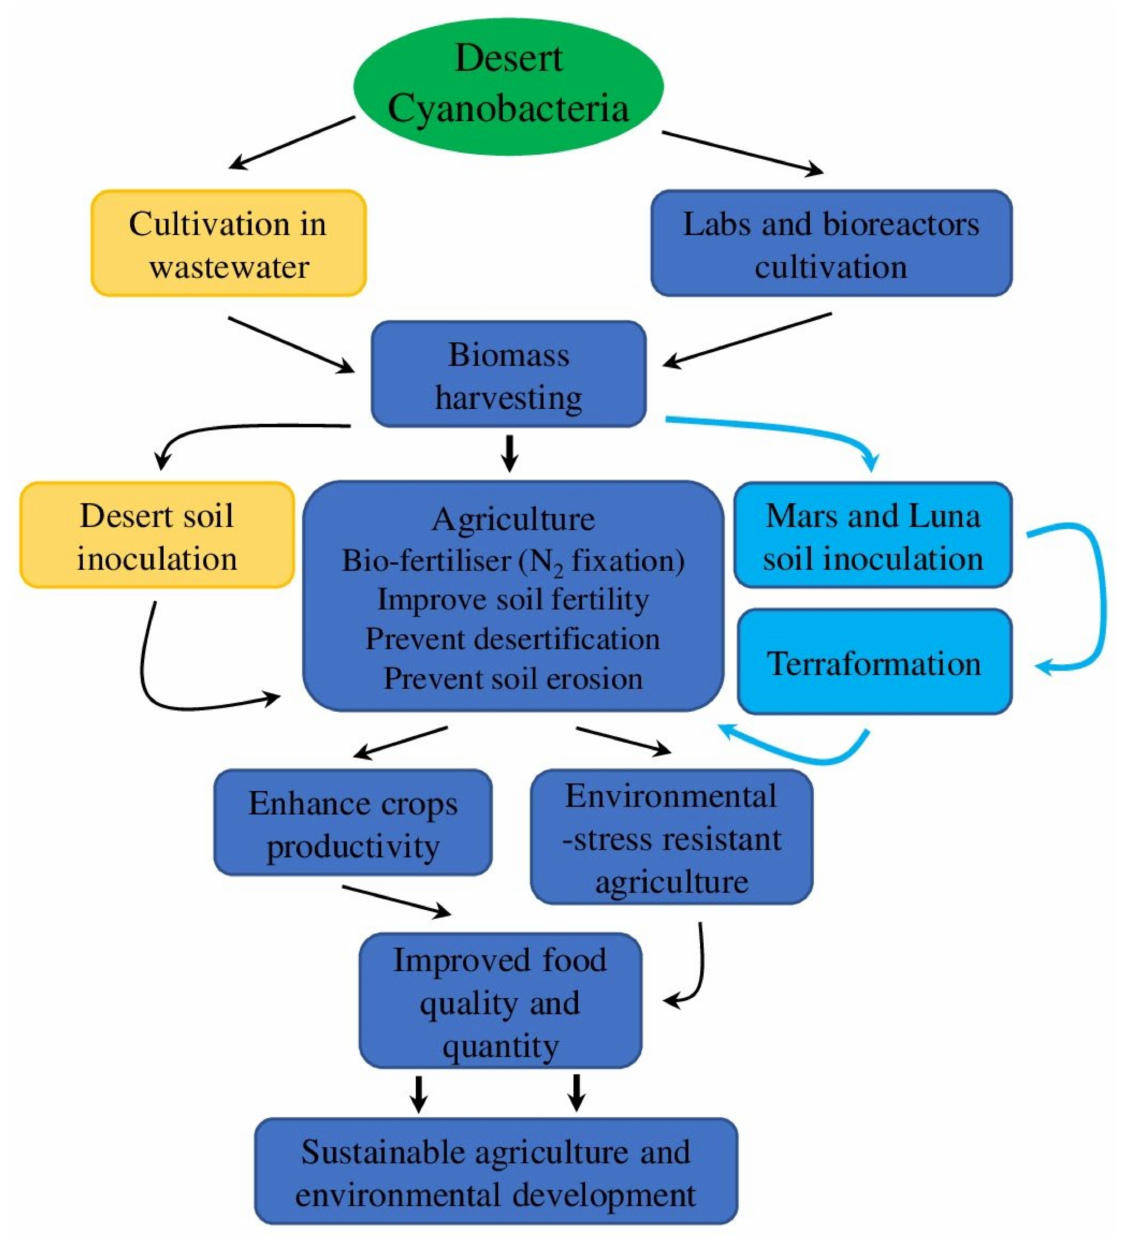
Figure 4. A hypothetical scheme exhibiting the potential roles of desert cyanobacteria. Potential application of desert cyanobacteria to solve ecological problems is shown in orange; future space exploration areas are shown in cyan; convenient ways to use desert cyanobacteria for sustainable agriculture and environmental management are shown in